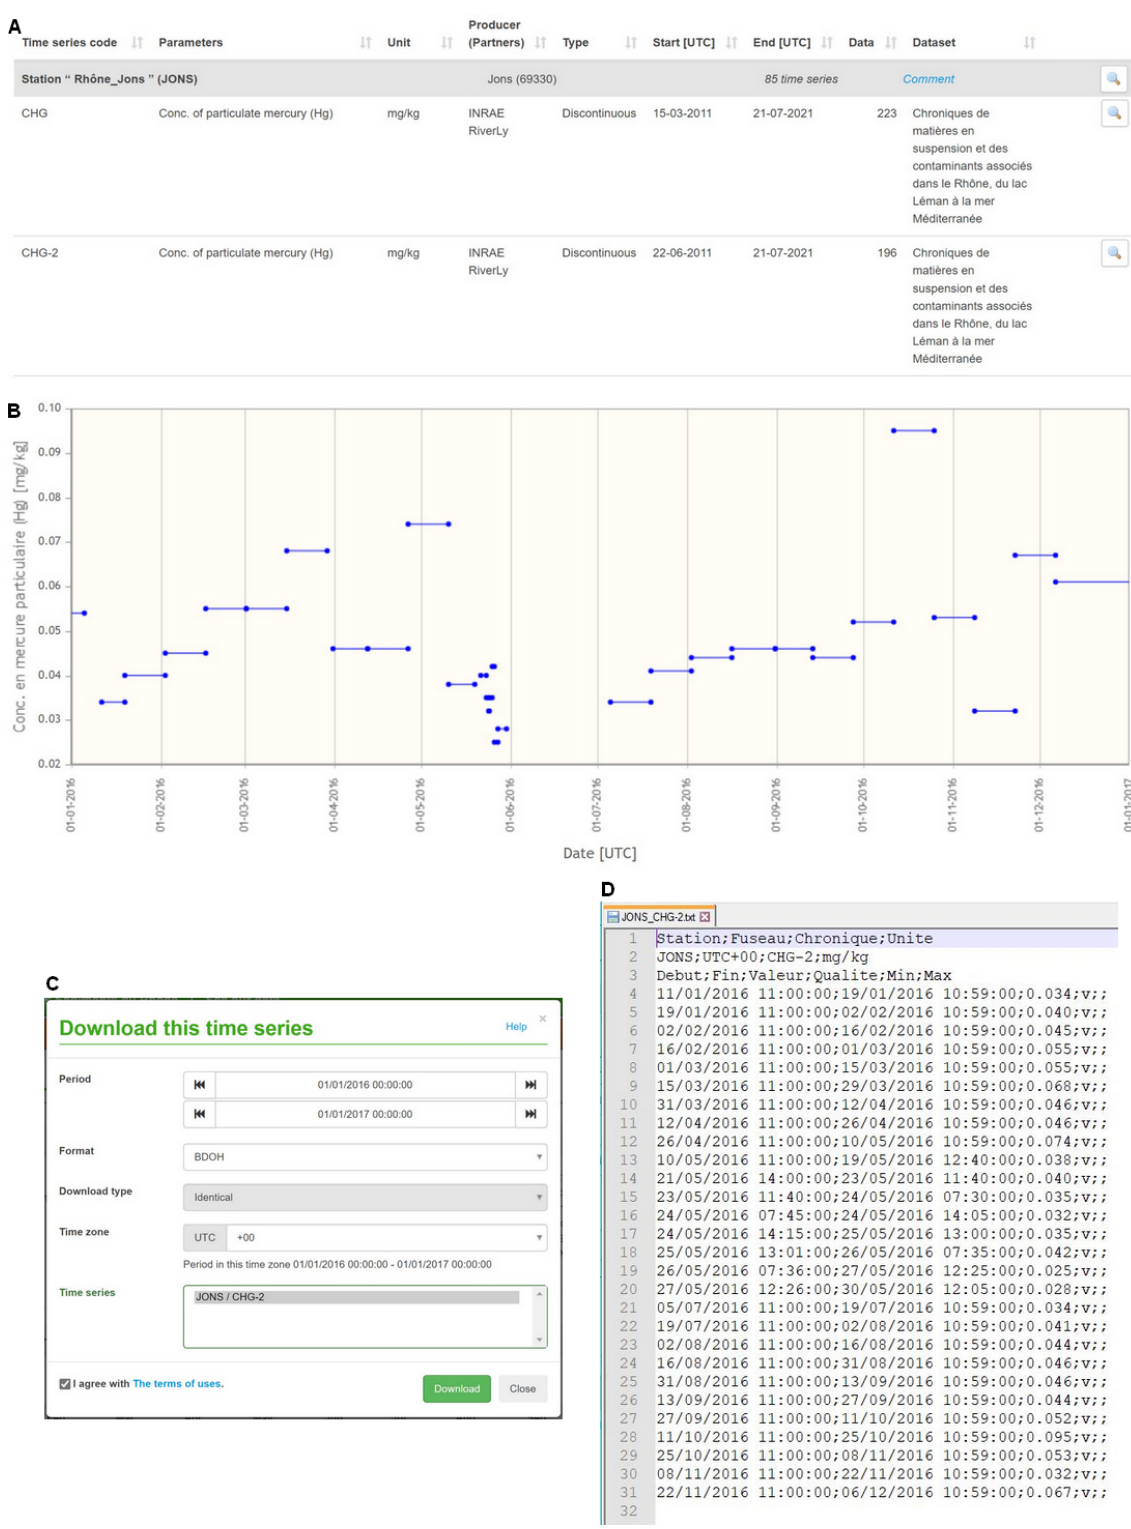
Figure 2. Example of time series available at the Rhône station at Jons in the BDOH OSR database: (a) Screenshot of mercury (Hg) time series with CHG for SPM sample collected by continuous flow centrifuge and CHG-2 for SPM sample collected by particle trap, (b) screenshot of the visualization of the time series CHG-2 in 2016, (c) screenshot of the window for choosing download parameters of the time series CHG-2 and (d) screenshot of the flat text file of the time series CHG-2 in 2016 and associated quality code (v = valid) using Notepad ++